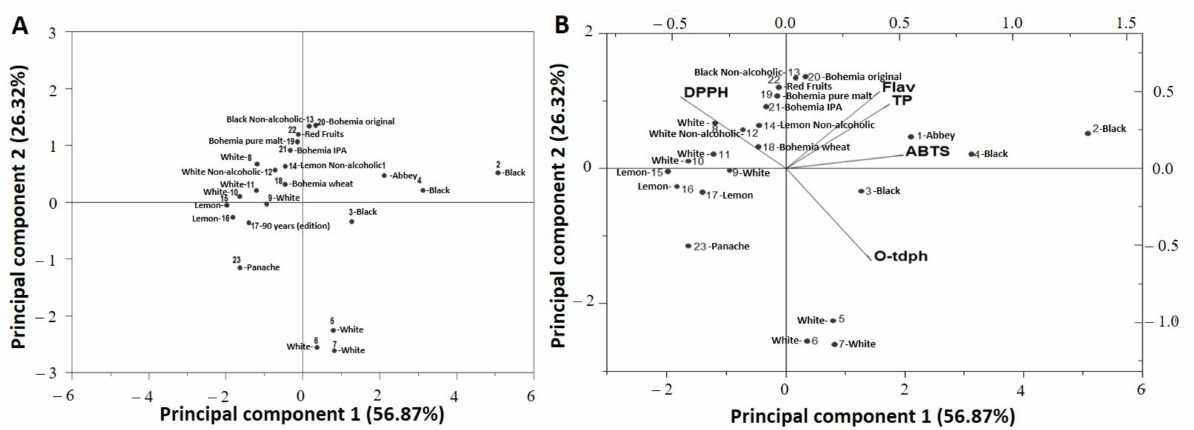
Figure 1. ( A ) Simple dispersion graph (Principal component 1 × Principal component 2) over the main sources of beer variability; ( B ) Projection of the values obtained for PCs 1 and 2 for the different samples. The weights of each variable for each of the factors are represented by the position of the abbreviations in the